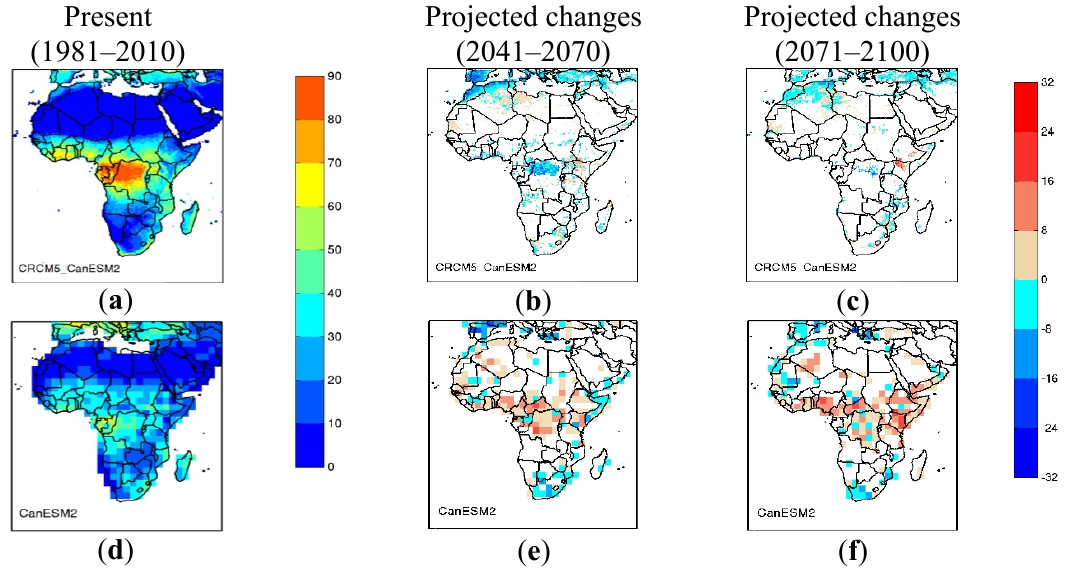
Figure 9. Same as Figure 6, but for annual mean number of dry